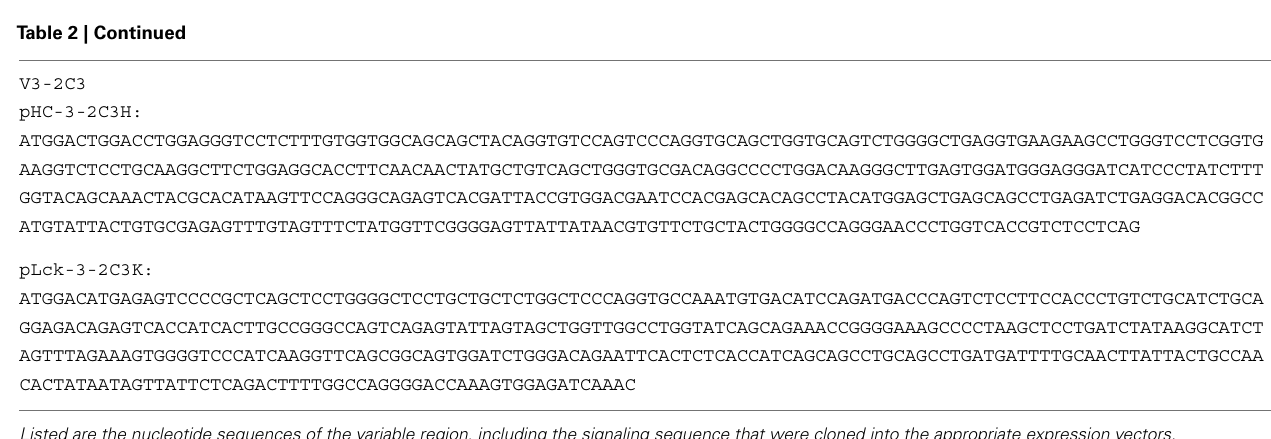
FIGURE 2 | Infection or vaccination with pdmH1N1 induces a dominant antibody response targeting the HA stem. (A) mAbs to the HA stem fail to inhibit hemagglutination but a minority of mAbs inhibit hemagglutination by pdmH1N1. All mAbs were at 40 μ g/ml and diluted 50% with virus in the first well. No detectable hemagglutination means that hemagglutination was not inhibited at 20 μ g/ml. (B) Anti-HA stem mAbs inhibit binding of a mouse mAb (C179 (Okuno et al., 1993)) to the HA stem in a competition ELISA. Note that mAb I5-52, not using IGHV1-69 , also inhibited C179 binding. (C) pH 5